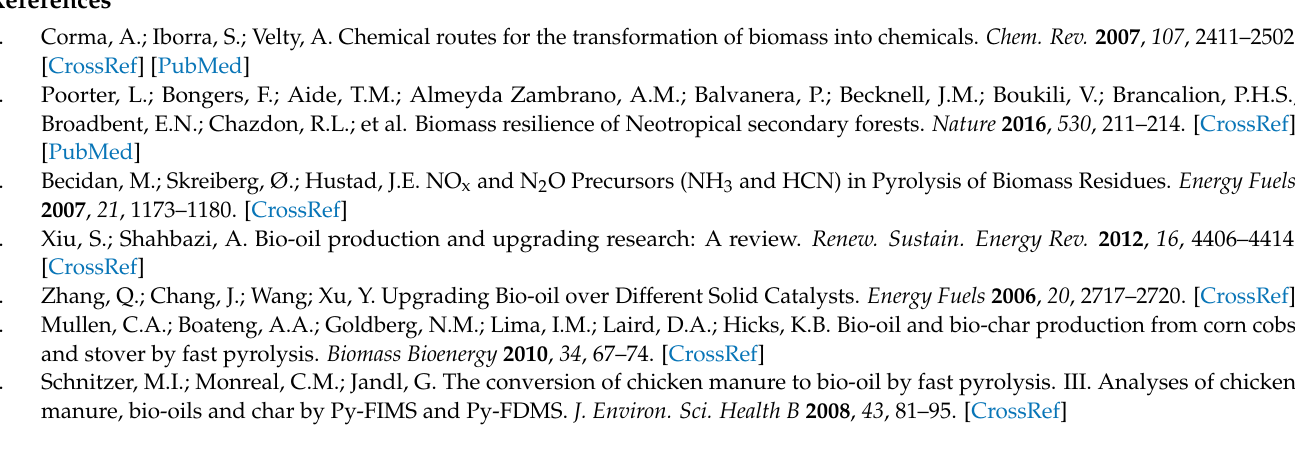
Table S8: LC-QTOF-MS analysis of bark ethanol/methanol